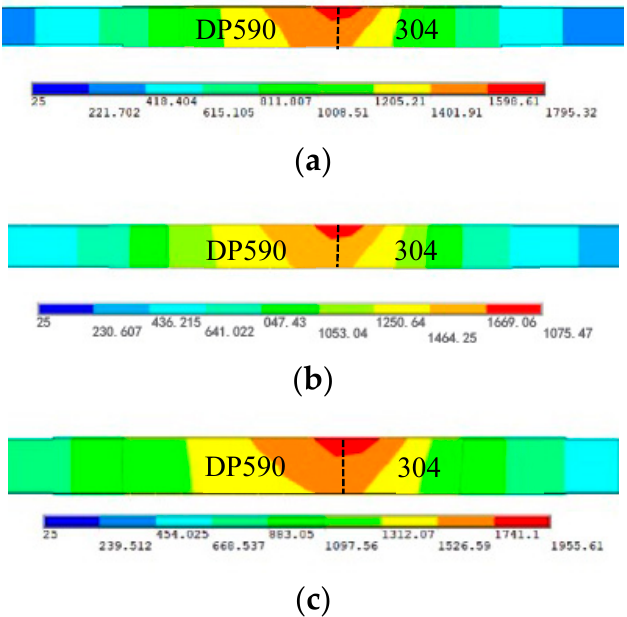
Figure 11. Two-dimensional temperature fields of DP590/304 weld with nickel coating under different pulse laser energies: ( a ) 15 J; ( b ) 17 J; ( c ) 19 J.